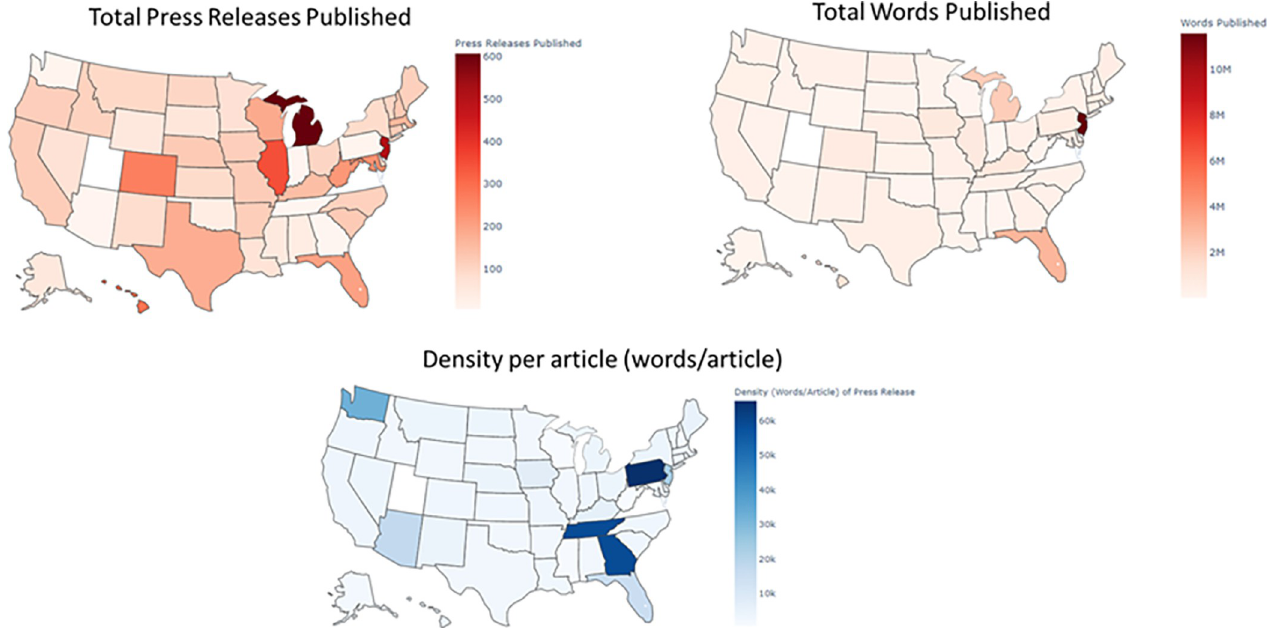
Fig 2. Comparison of total press releases, number of words, and density of words per article for all US states.